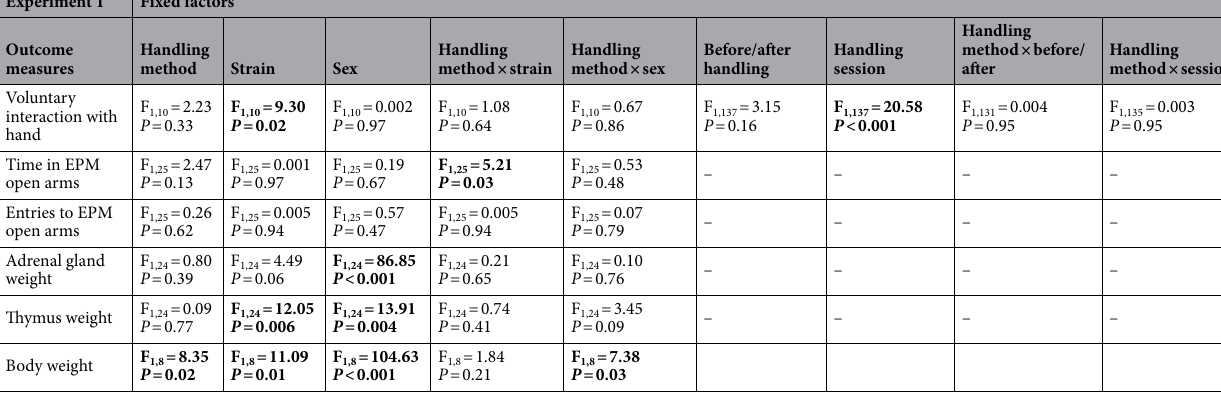
Table 1. Test statistics for the full models run in Experiment 1, where mice were handled daily for nine days. Handling method, strain and sex were included as fixed factors and home cage nested in experimenter was included as a random factor. "Handling method × sex" and "handling method × strain" interactions were included in the model. For VIT, handling session (1st, 5th or 9th day), and handling order (before or after handling) were added to the model as explanatory variables and additionally all interactions with the handling method were fitted. Significant values are in